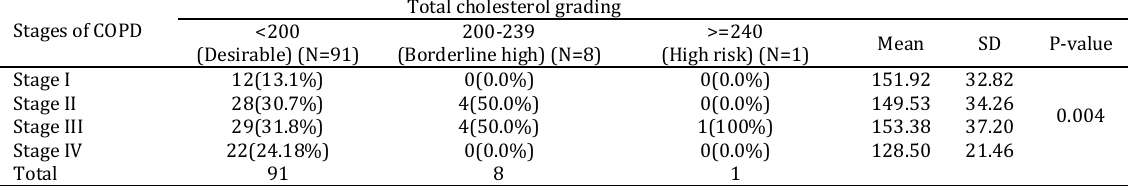
COPD: chronic obstructive pulmonary disease Table 2. Total cholesterol in relation to chronic obstructive pulmonary disease stages